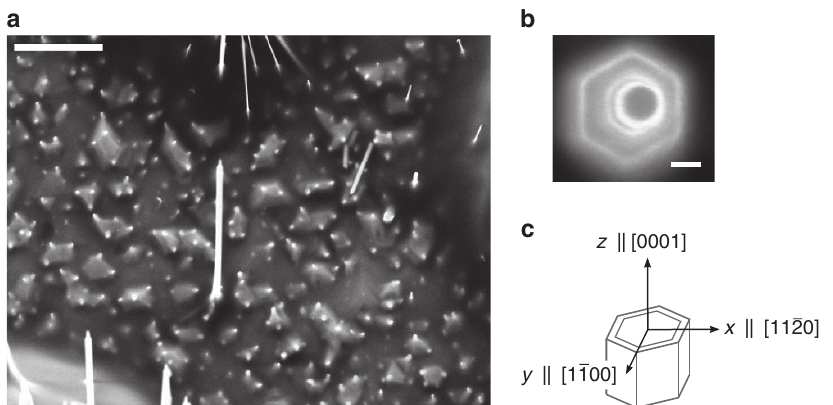
Figure 1 | Free-standing WZ GaAs/AlGaAs core/shell NWs. ( a ) Representative scanning electron microscopic image of a single, free-standing NW used for optical spin orientation experiments. Scale bar, 2 m m. ( b ) Top-view image of the NW in a , showing the solidified hemispherical catalyst droplet atop the hexagonal NW. Scale bar, 50nm. ( c ) Schematic representation of the core/shell NW and the orientation of the coordinate system with respect to its axis, denoted as the z|| [0001]